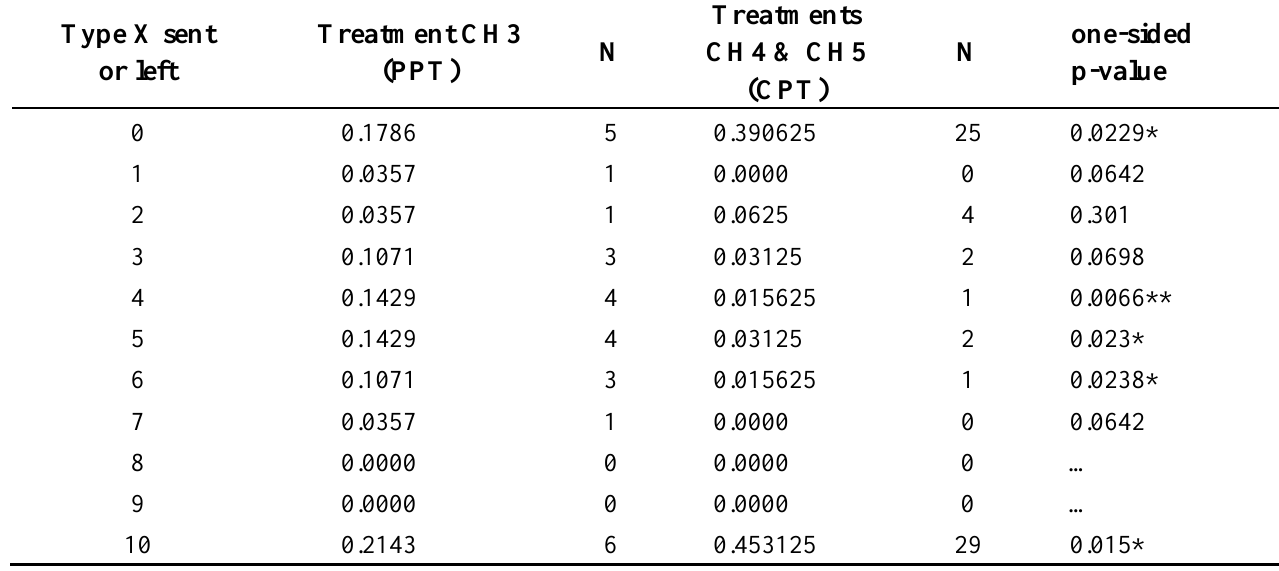
Table 4. Proportions tests of Type X data for CH3 and pooled CH4 and